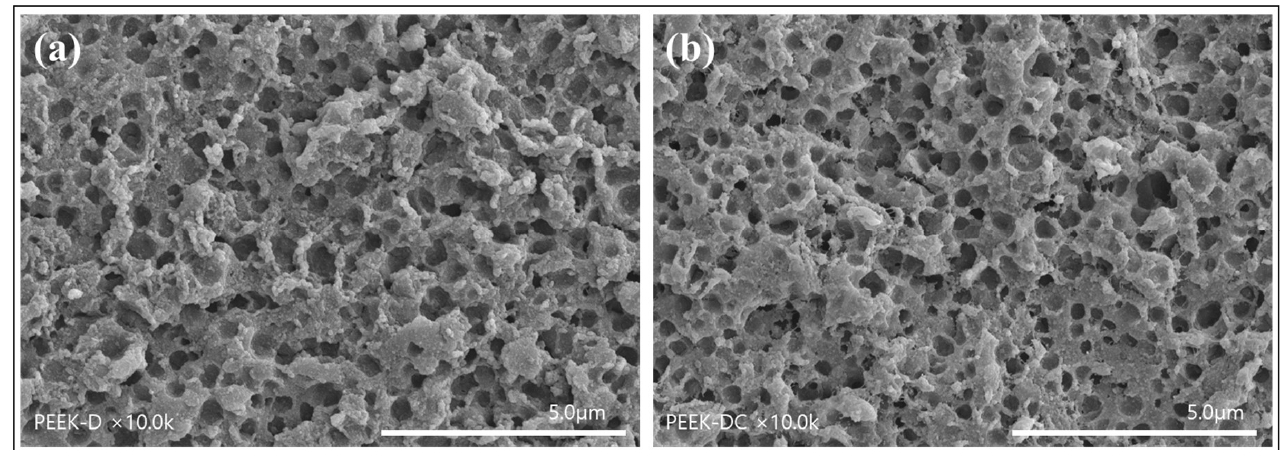
Figure 3. SEM images of PEEK implants at various magnifications after treatment with a mixed acid of sulfuric acid and nitric acid under ultrasound for 90 s and then washing with distilled water for 6 h under ultrasound.